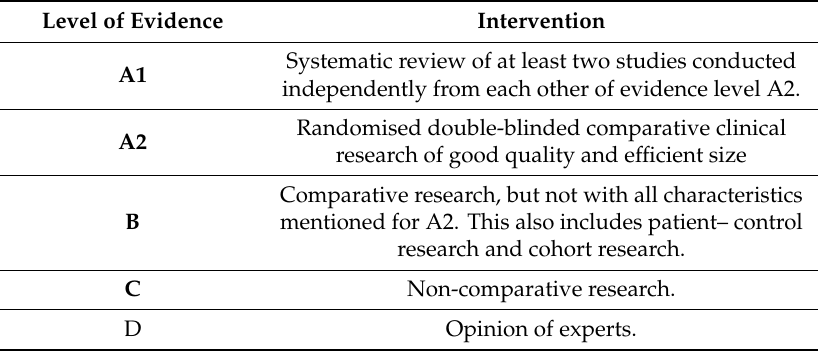
Table 5. Level of